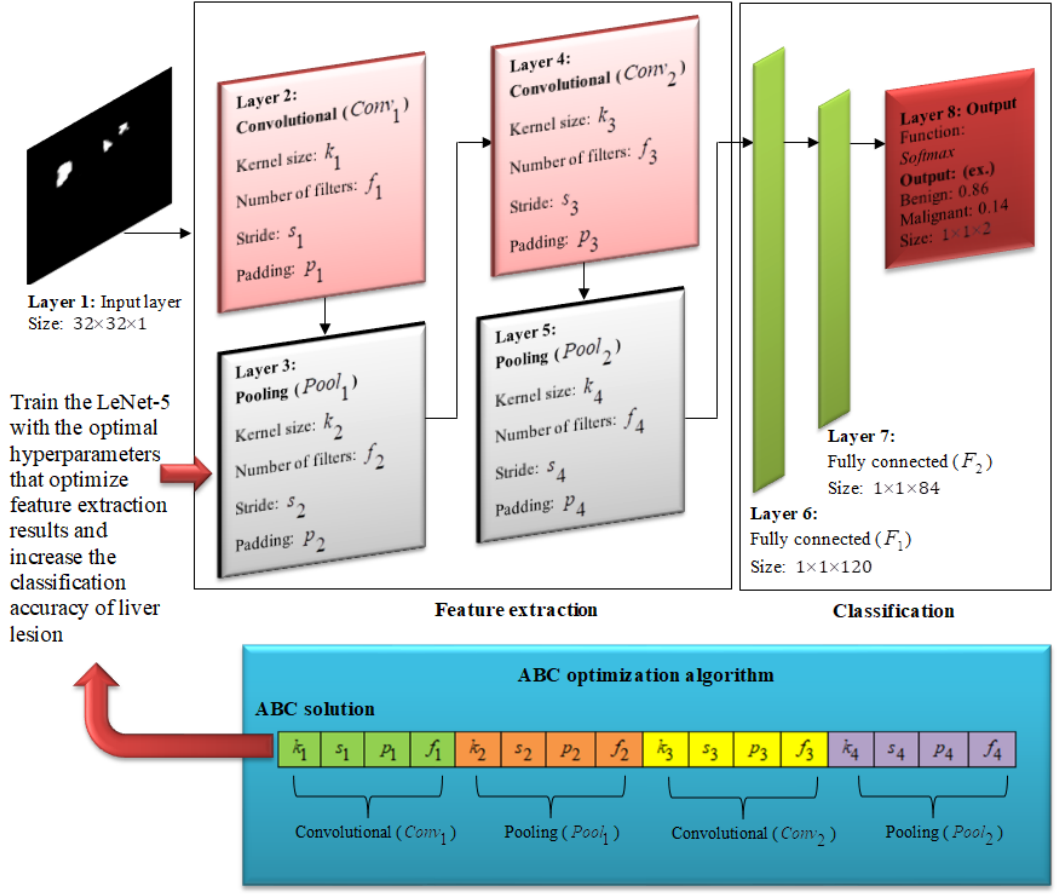
Figure 10. Optimization model of the LeNet-5 network structure, in which the ABC algorithm determines an optimal topology for constructing LeNet-5 by selecting optimal values for kernel size, padding, stride, and number of filters applied at each convolution and pooling layer. Then the LeNet-5 network is trained with the resulting values to optimize the feature extraction step and increase classification accuracy of liver lesions.